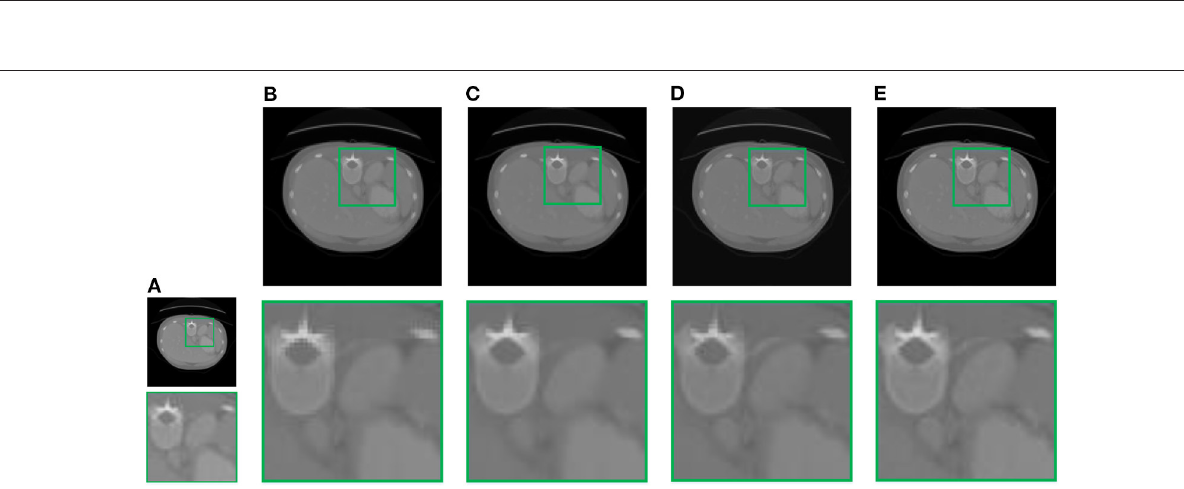
Frontiers in Neuroinformatics |